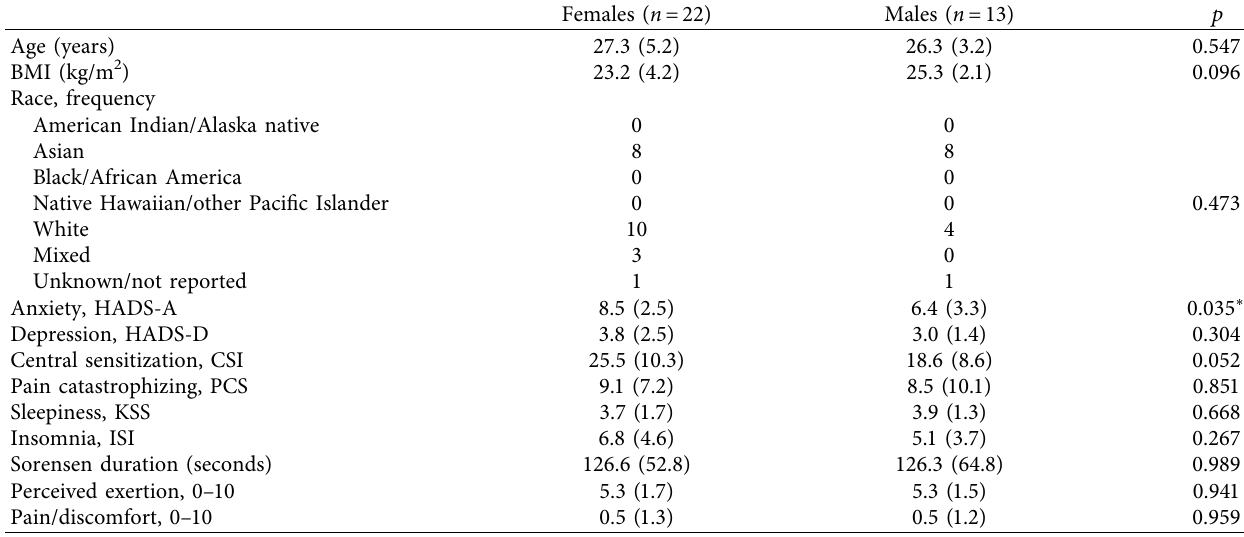
Table 1: Participant demographic characteristics, psychosocial characteristics, and the Sorensen test